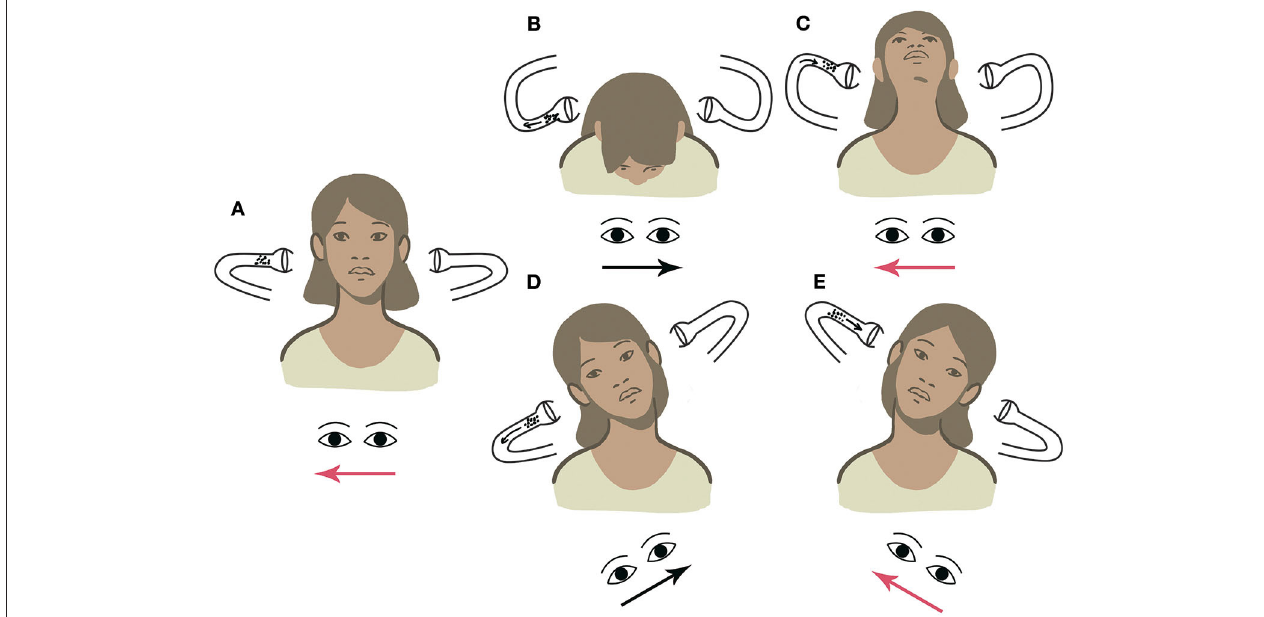
FIGURE 6 | UBP for right apogeotropic LSC-BPPV. (A) PSN: right beating. (B) HPT with forward head bending: left-beating nystagmus. (C) HPT with backward head bending: right-beating nystagmus. (D) UHRT with rightward head tilt: left-beating apogeotropic nystagmus. (E) UHRT with leftward head tilt: right-beating apogeotropic nystagmus.